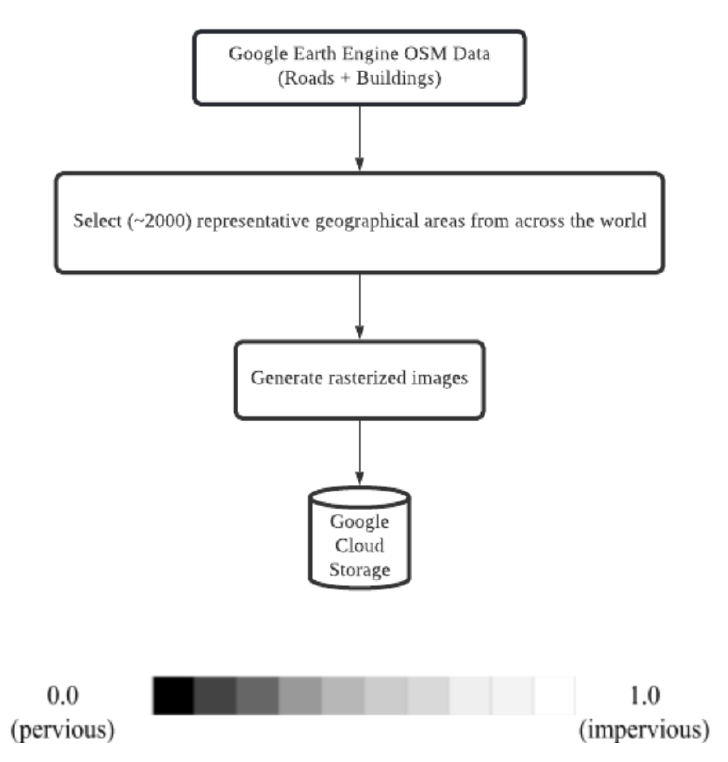
Figure 3. Process for generating OSM patches representing impervious surfaces. Each pixel in the rasterized OSM patch takes a value between 0 and 100, representing the percentage of impervious surface.